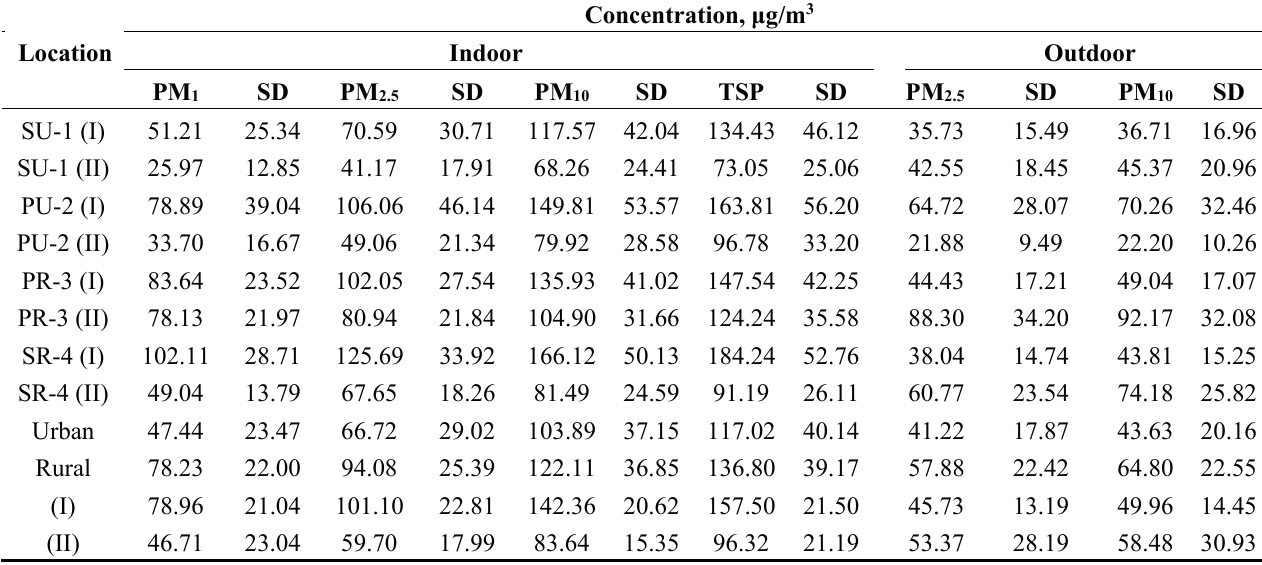
Table 3. Average levels of PM fractions ( μ g/m 3 ) measured during occupancy periods ( N = 48); (I) - Older, (II) - Younger children classrooms. Concentration, μ g/m 3 Location